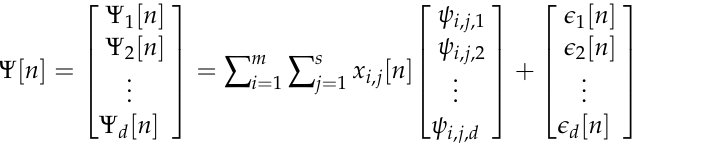
Figure 1. Graphic representation of NILM process